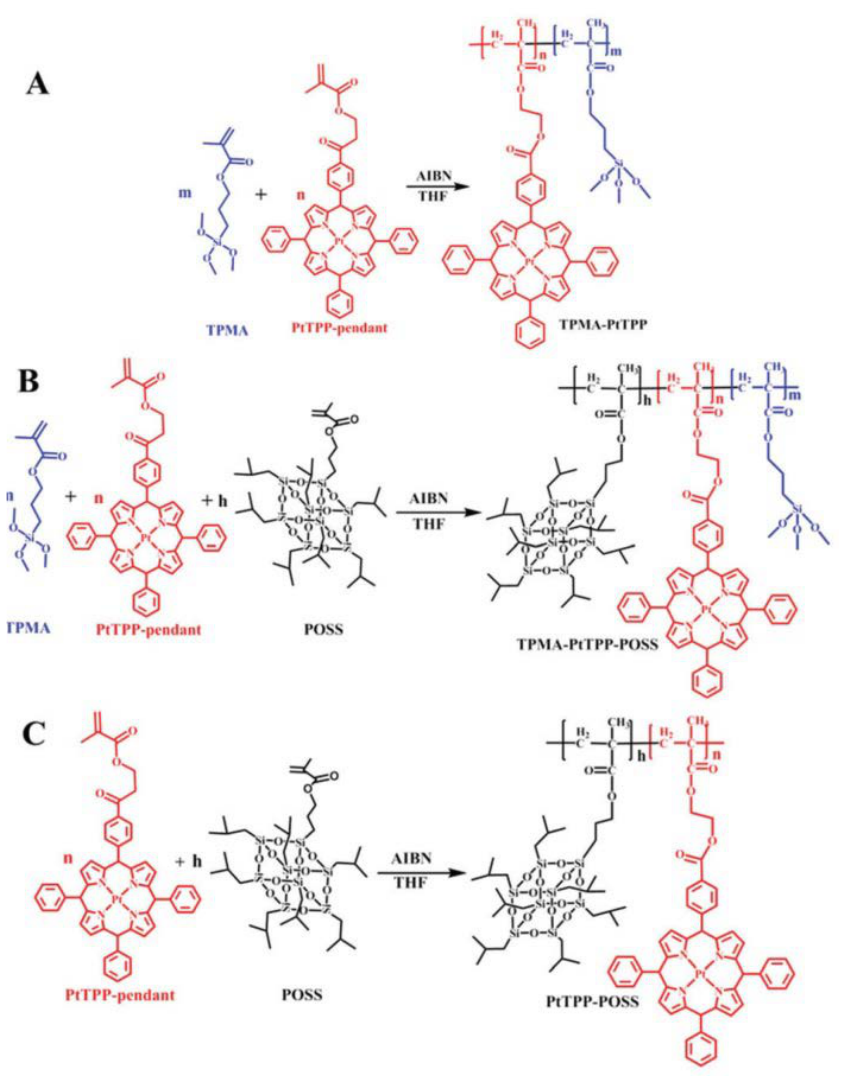
Figure 18. Syntheses of the oxygen-sensitive copolymers of TPMA–PtTPP ( A ), TPMA–PtTPP–POSS ( B ), and PtTPP–POSS ( C ) copolymers. Reprinted with permission from [139]. Copyright (2017) The Royal Society of Chemistry.